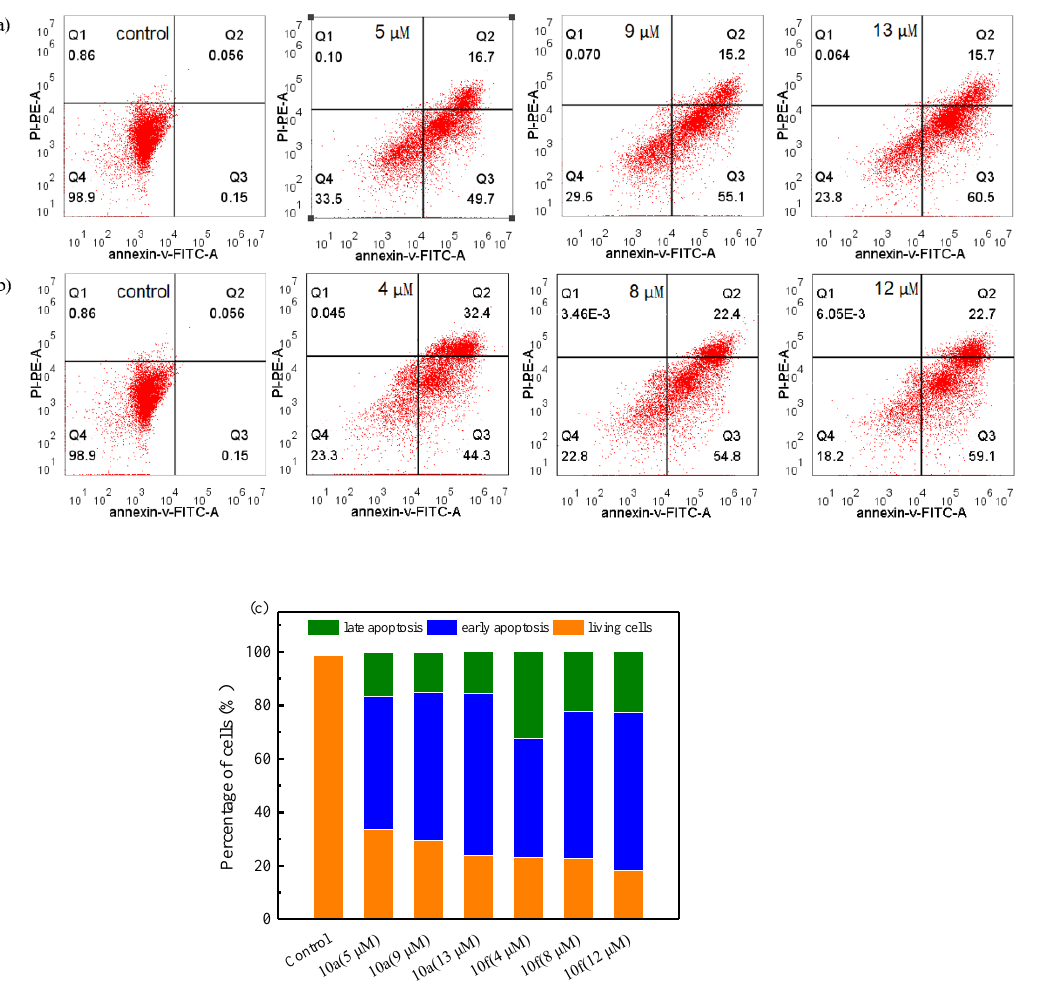
Figure 4. Apoptosis of BGC-823 cells treated with ( a ) 10a (0 μM, 5 μM, 9 μM, and 13 μM) and ( b ) 10f (0 μM, 4 μM, 8 μM, and 12 μM) for 48 h. ( c ) The percentage of cells in each zone (late apoptosis, early apoptosis, and living cells) after BGC-823 cells were incubated with 10a and 10f for 48 h.